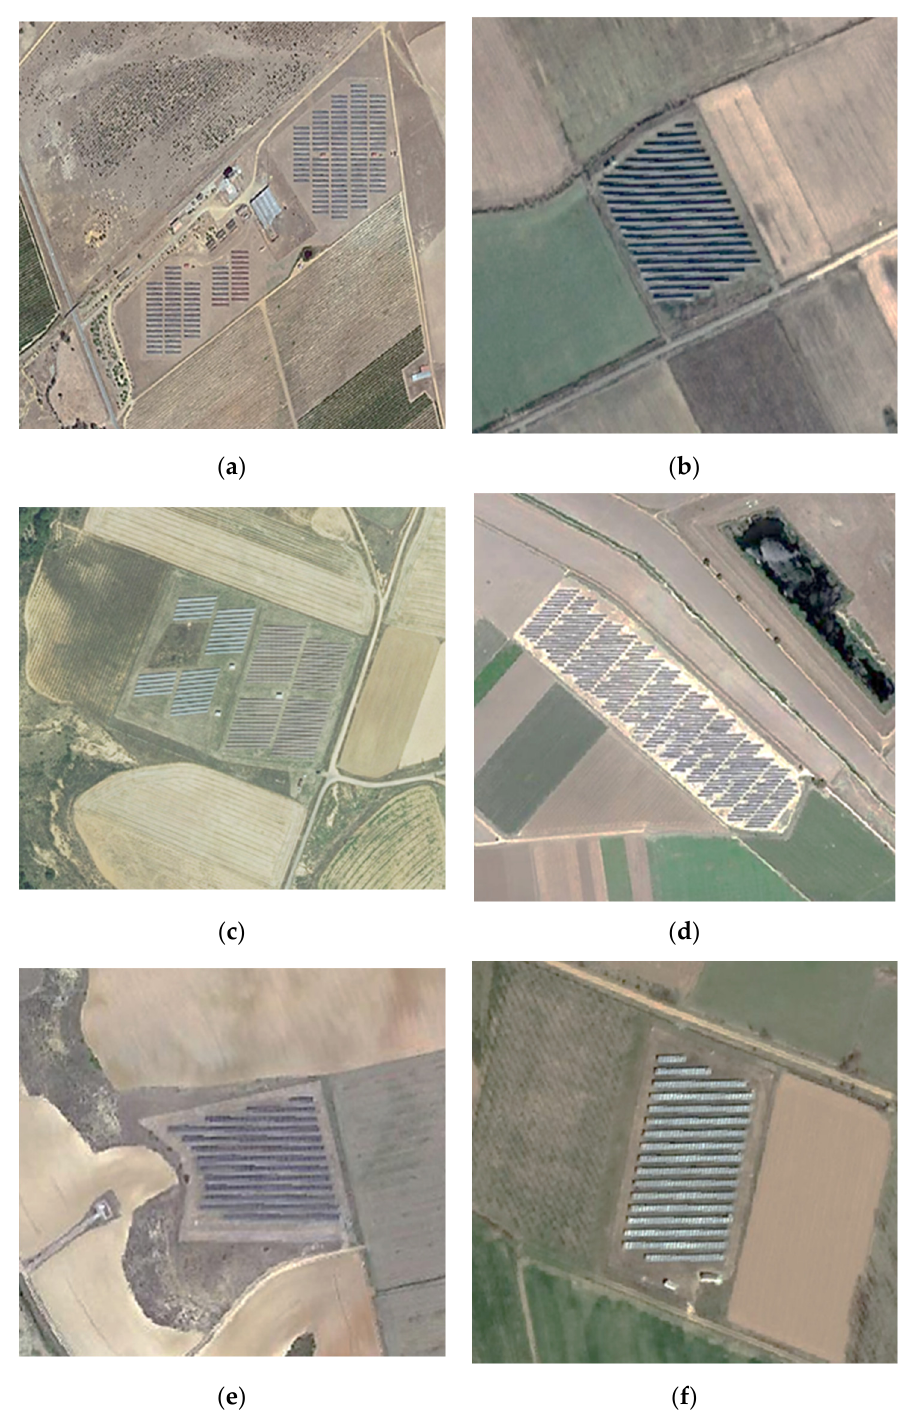
Figure 8. Photovoltaic plants analyzed with INSPECTORMAP to validate the tool performance: ( a ) plant 1, ( b ) plant 2, ( c ) plant 3, ( d ) plant 4, ( e ) plant 5, and ( f ) plant